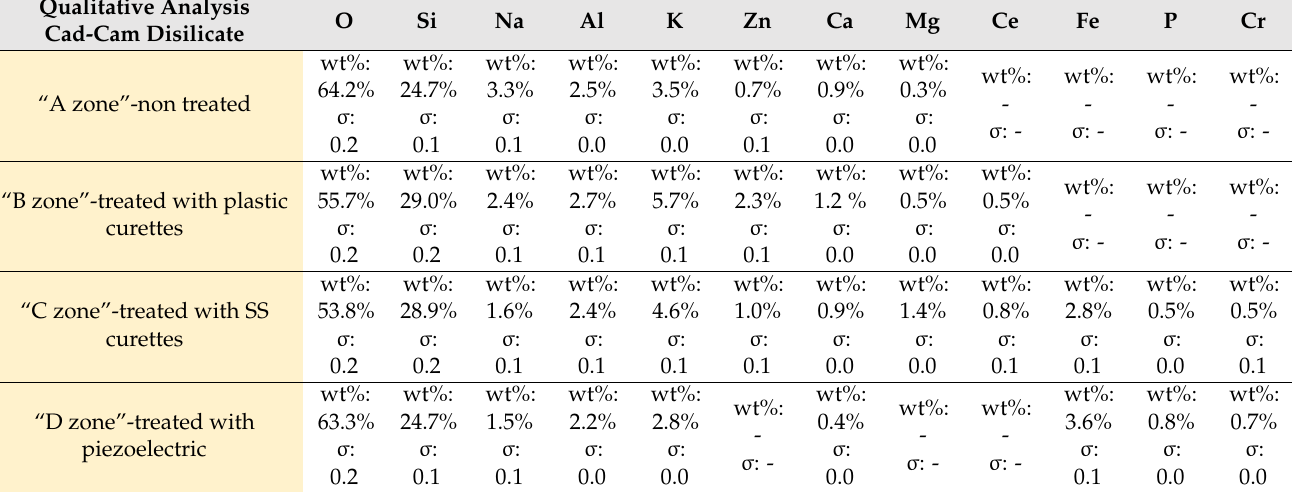
Table 2. Pressed Lithium Disilicate.